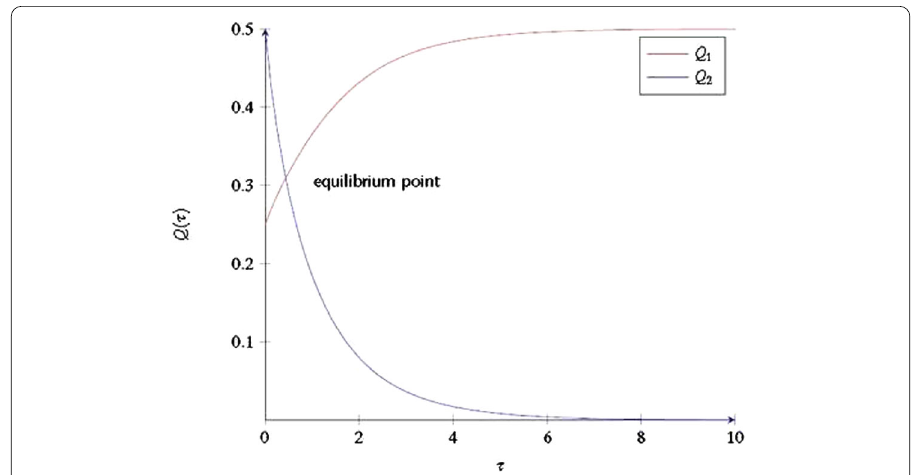
Figure 3 Example 3: the functions α = 0.88, Q ( τ ) with respect to τ . There is a unique equilibrium point for the system corresponding to a unique